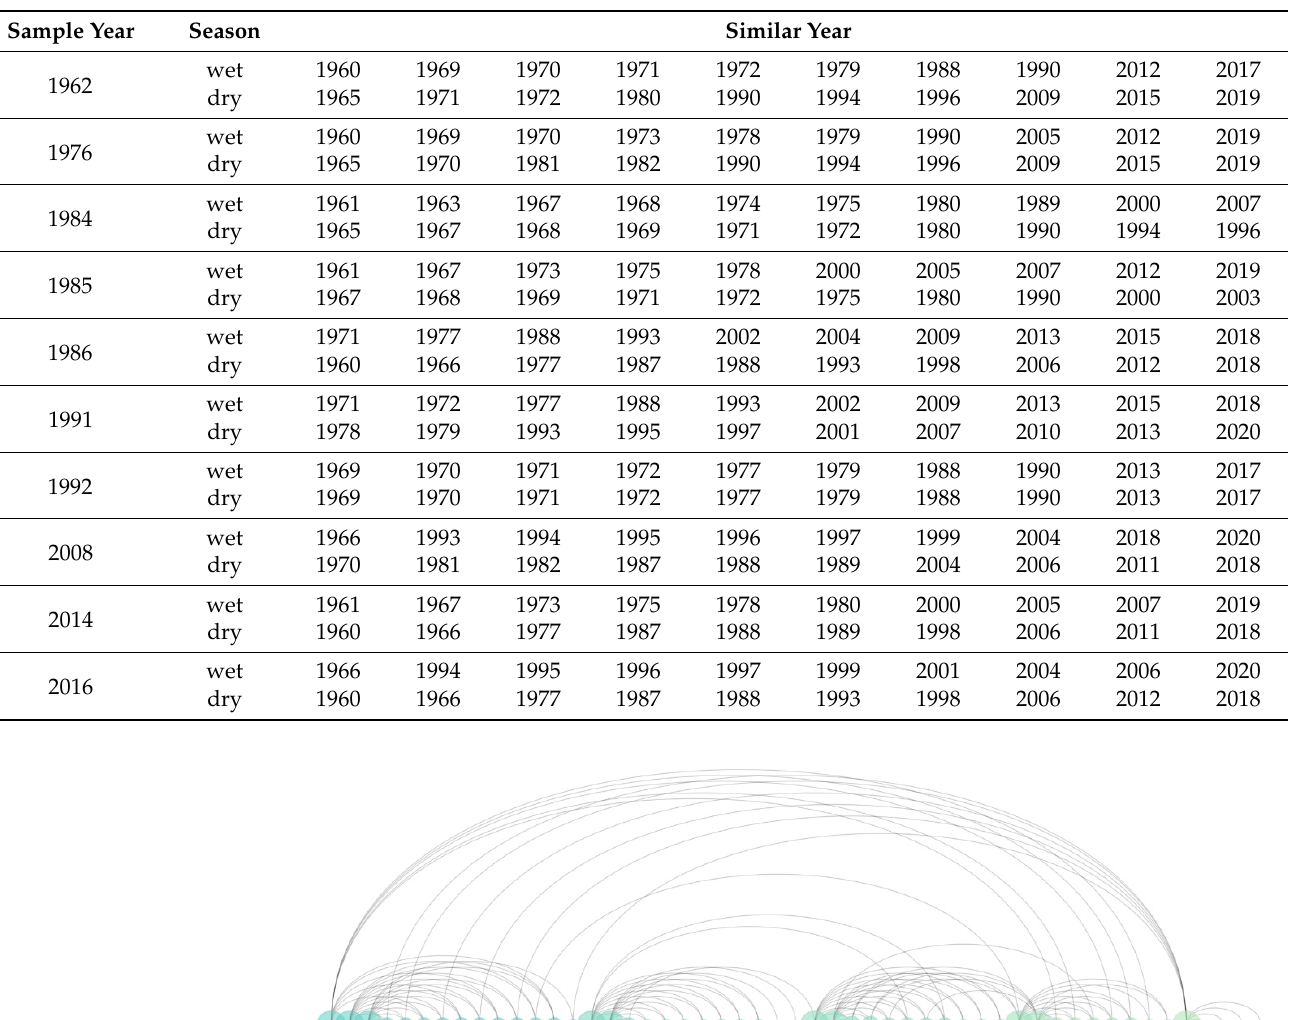
Table 4. Sample year and corresponding similar year.